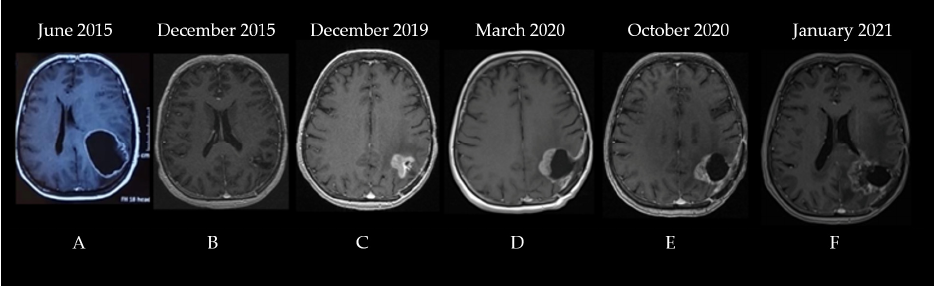
Figure 3. The patient’s disease progression showcased through serial brain MRI imaging (( A )—left frontoparietal process with a heterogeneous signal and structure, irregular margins, and both solid and cystic components surrounded by moderate edema, which compressed and tractioned the trigon and body of the left lateral ventricle upward, ( B )—left parietal postoperative cavity with discrete wall contrast enhancement, minimal traction over the occipital horn of the left lateral ventricle, and midline structures in normal position, ( C )—vascularized tumoral tissue on the medial and superior wall of the postsurgical resection cavity with perilesional edema, ( D )—postoperative cavity and residual tumor after second surgery, ( E )—postoperative cavity after second surgery with progression of residual tumor, ( F )—further progression of residual tumor coupled with radiation induced changes).